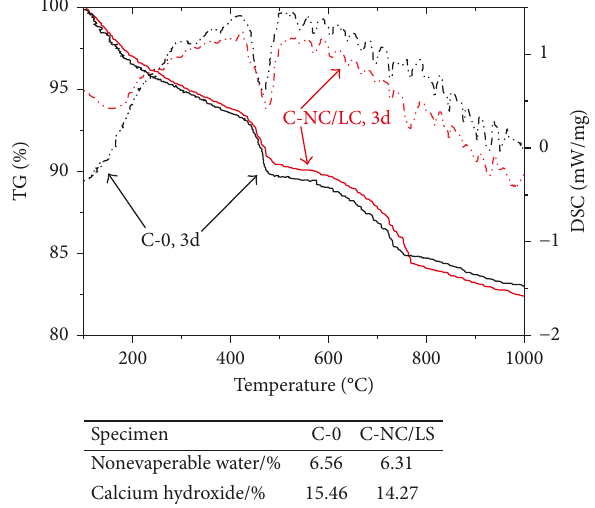
Figure 8: DSC-TG curves of specimens.